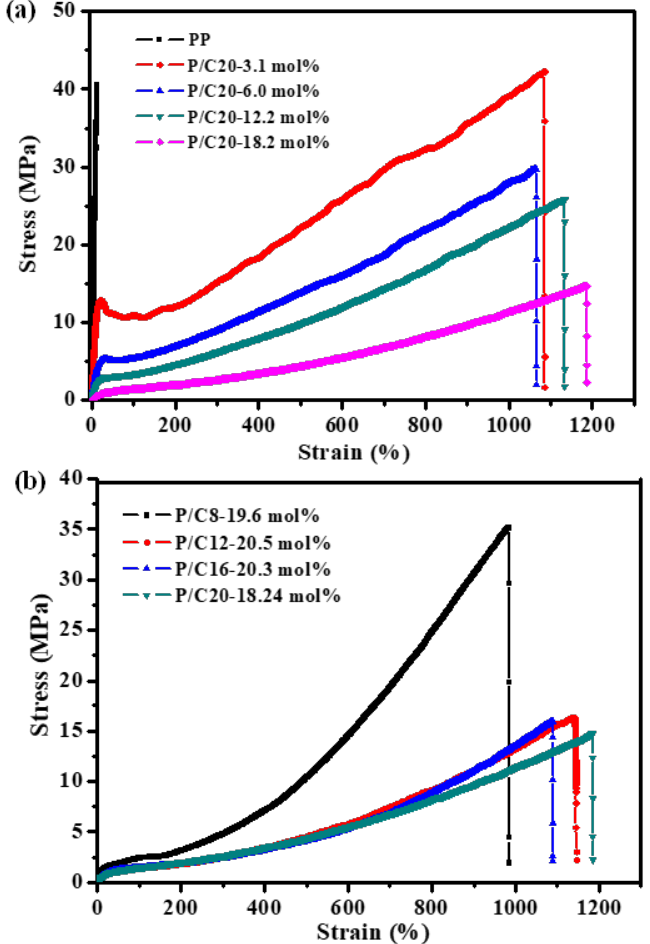
Figure 3. Stress-strain curves of the typical copolymers: ( a ) P/C8 and other poly (propylene- co -α-olefin) s with similar comonomer incorporation, ( b ) P/C20 with different 1-eicosene incorporation. Table 2. The value of mechanical properties for random poly (propylene-co- α -olefin)s.